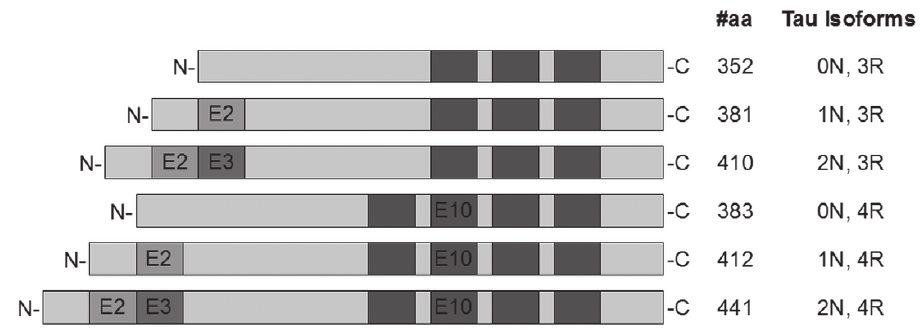
Figure 1 - Representation of the six tau isoforms generated in the human brain from the alternative splicing of exons 2, 3 and